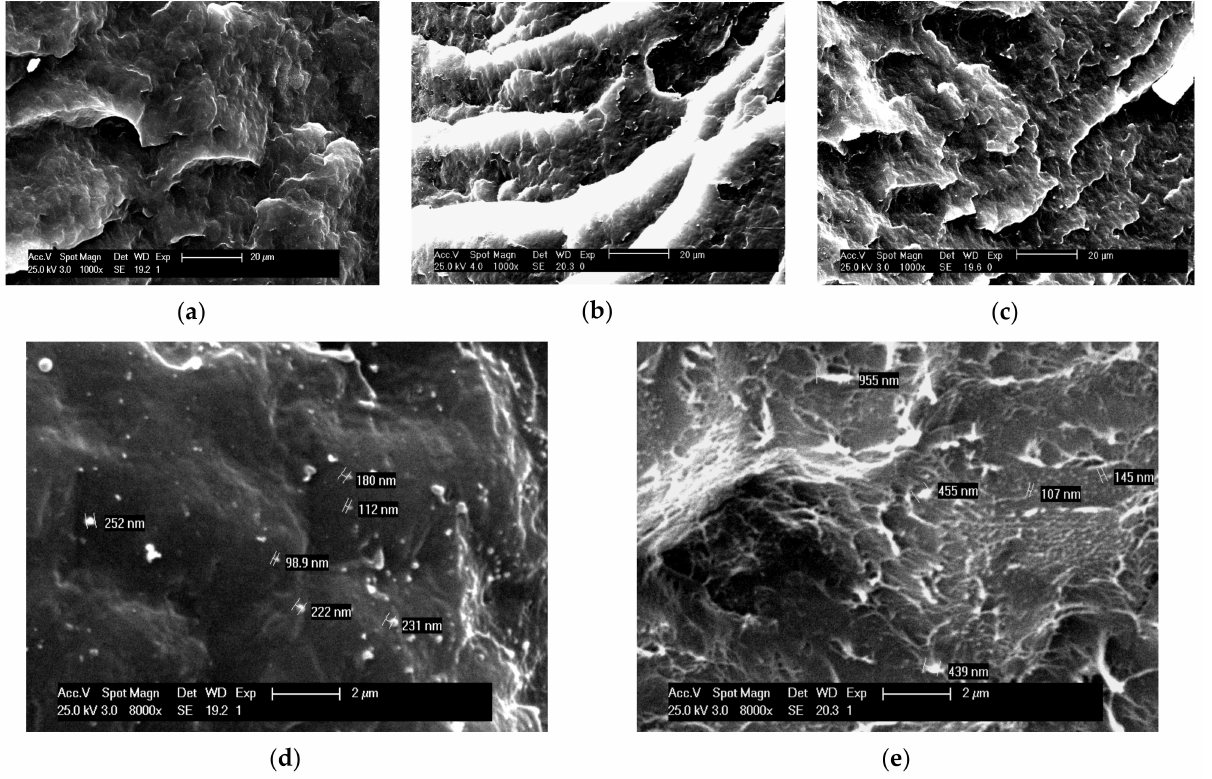
Figure 2. SEM images at a magnification of 1000 × for: ( a ) HMP; ( b ) HMP5GHS; and, ( c ) HMP5GLS. SEM images at a magnification of 8000 × for: ( d ) HMP5GLS and ( e )